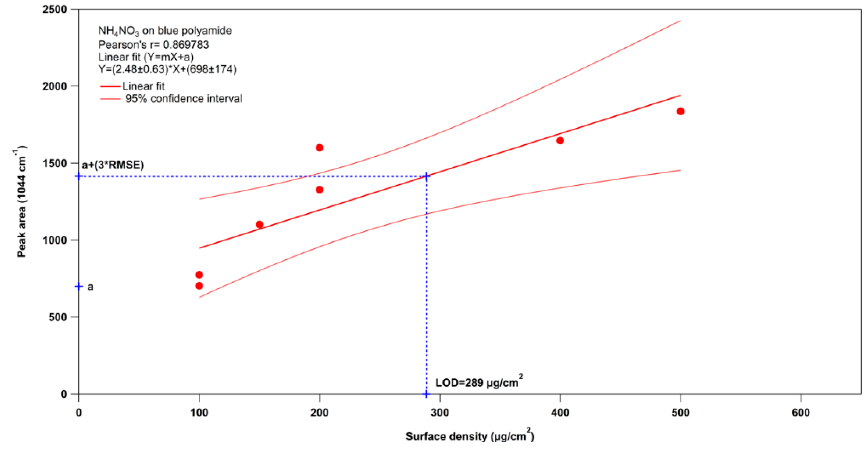
Figure 9. Limit of detection for AN deposited on blue polyamide.